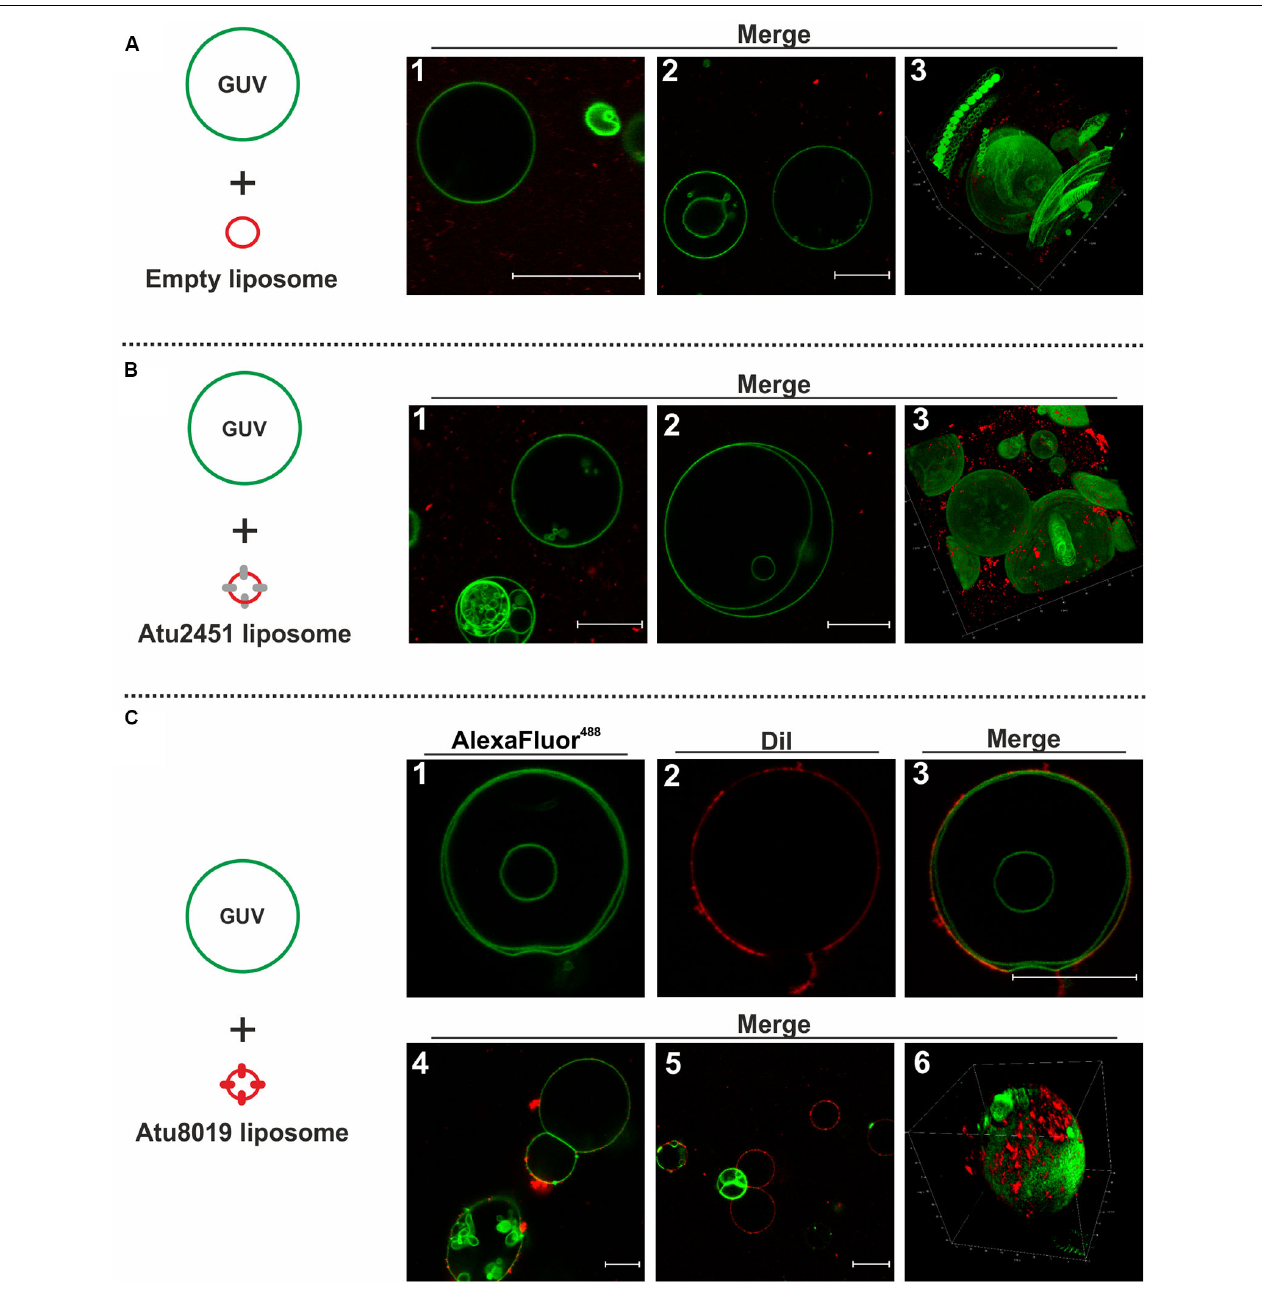
FIGURE 7 | Atu8019 HIS proteoliposomes interact with model membranes. Interaction of Atu8019 proteoliposomes with giant unilamellar vesicles (GUVs). Left side shows a schematic illustration of the used liposomes in the corresponding experiment. Green-fluorescent GUVs (DOPC, AlexaFluor488-PE) were incubated for 5 min with red-fluorescent (proteo)liposomes (DOPC, DiI) and subjected to confocal scanning microscopy. Interaction of empty liposomes (A) , Atu2451 proteoliposomes (25 proteins/vesicle; B ) and Atu8019 proteoliposomes ( C1 - 3 : 25 proteins/vesicle; C4-6 : 100 proteins/vesicle) with GUVs. A3 , B3, and C6 represent Z-stack images. All images were obtained at RT in microscopy buffer. Scale bars: 20 µ